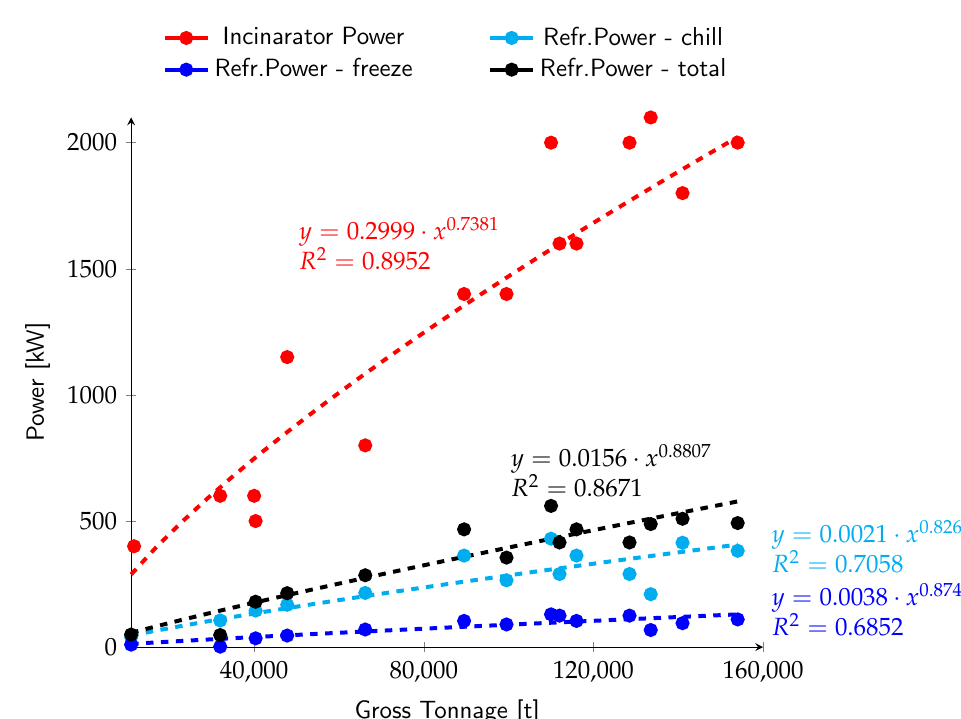
Figure 4. Power of one of the incinerators and the refrigeration plants compared with GRT of cruise ships (DATA: courtesy of Fincantieri jsc).